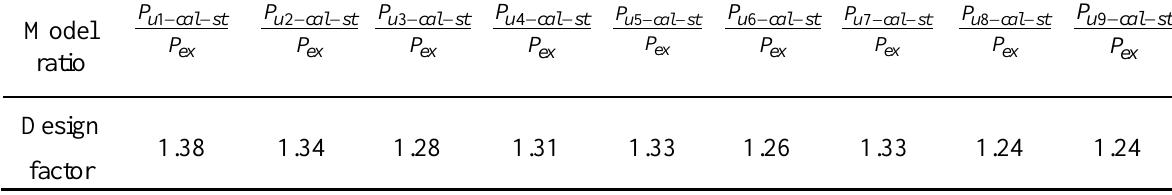
Table 7. Design factors for the calibrated models considering